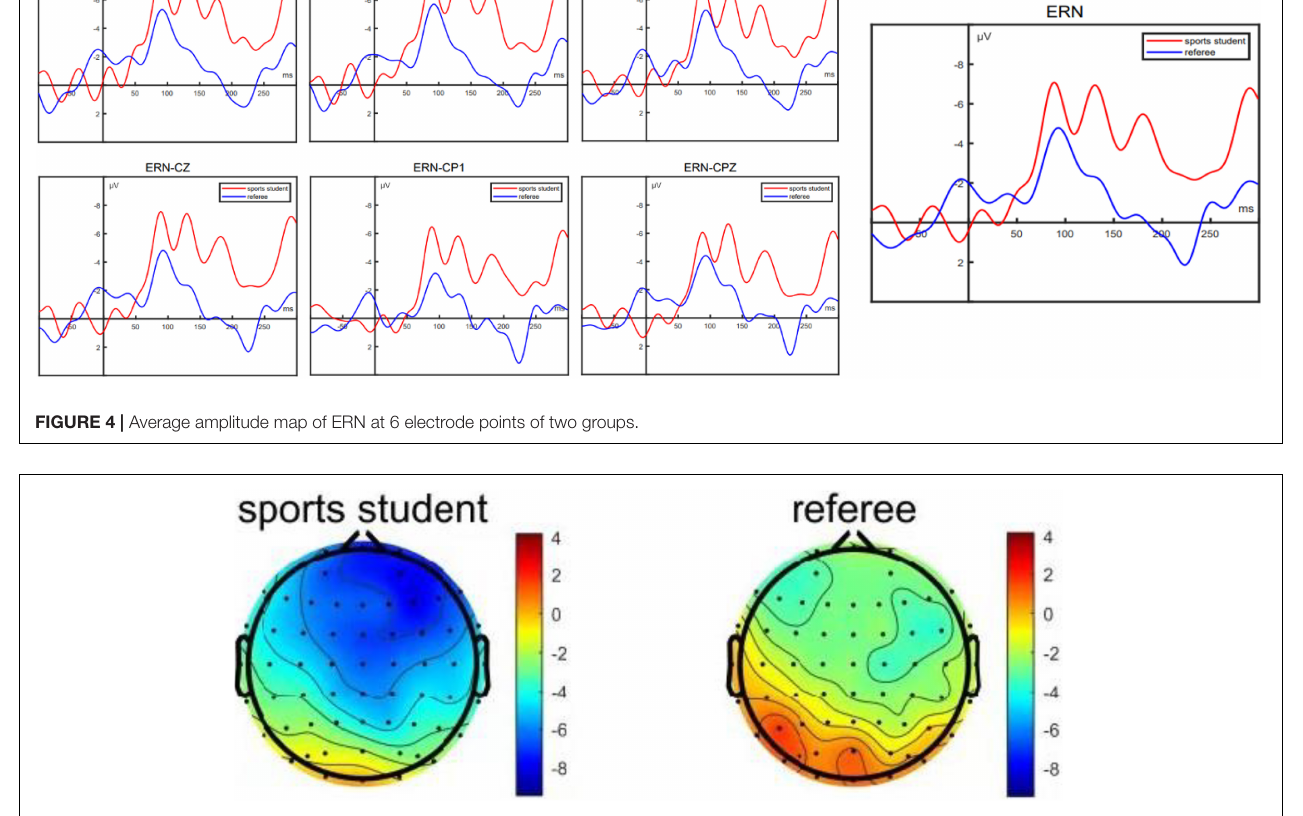
FIGURE 5 | EEG distribution of ERN of two